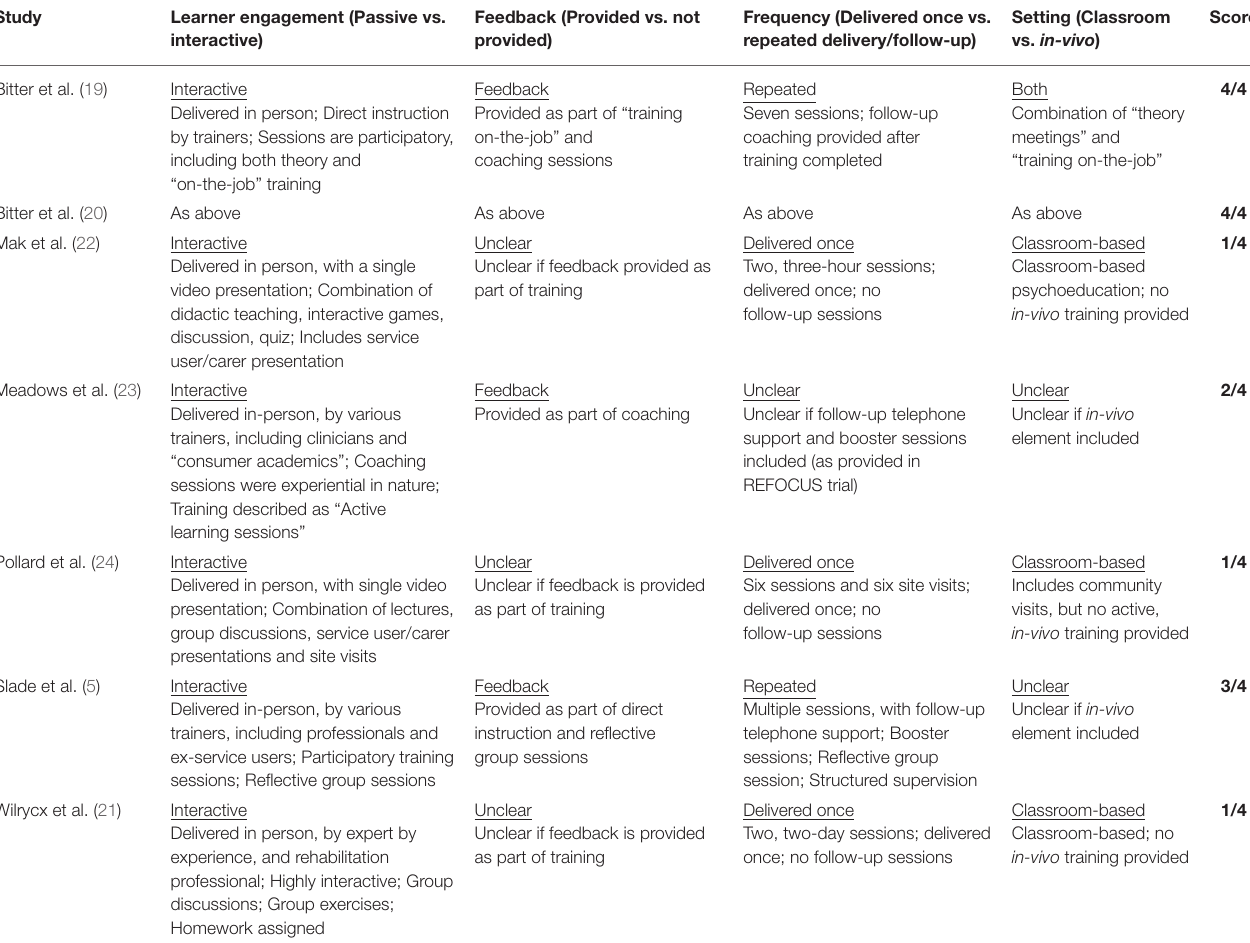
TABLE 2 | Training design and delivery characteristics of the included studies [scorecard adapted from (16)].